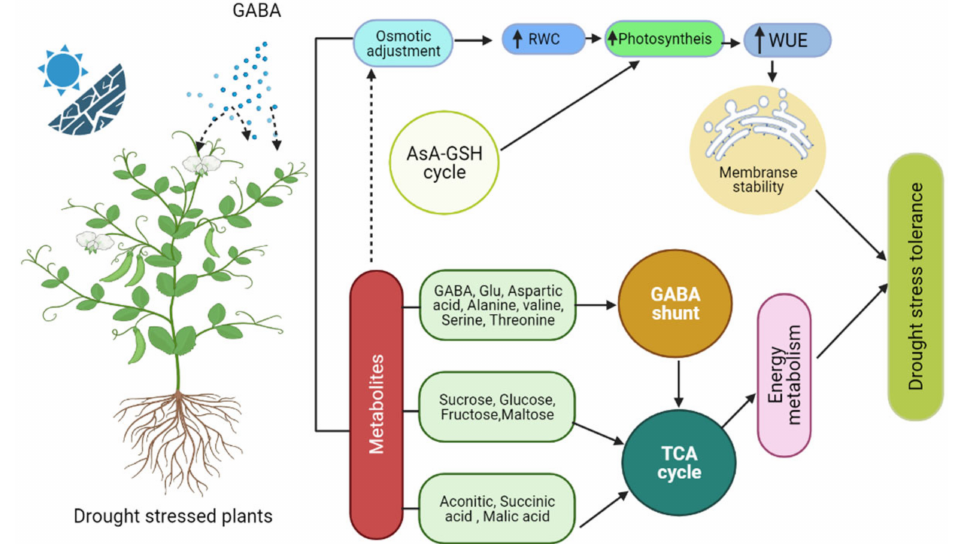
Figure 2. A proposed model demonstrates how GABA protects plants from drought stress. The protective role of GABA against drought-stress-induced oxidative damage has been demonstrated in a variety of plant species (Figure 2). In Phaseolus vulgaris L., for example, exogenous foliar application of GABA increased fresh shoot weight, dry shoot weight, and leaf area. Through osmotic adjustment, GABA improved drought tolerance in Phaseolus vulgaris L. [37] (Table